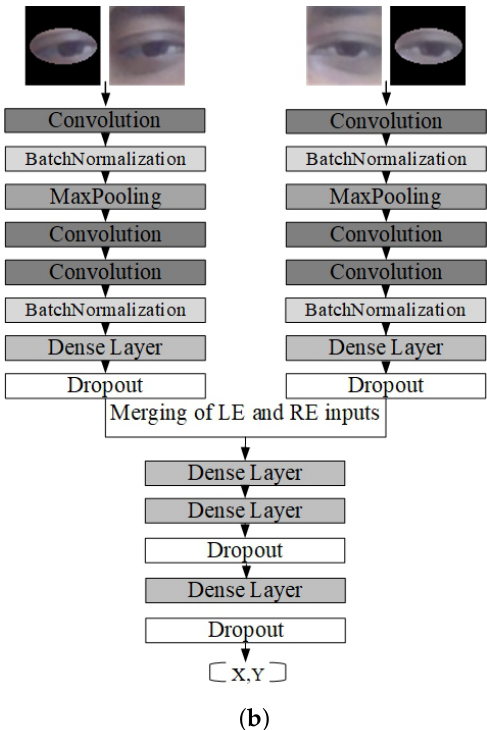
Figure 3. The architectures of the network used in the study. ( a ) Architecture that takes normal eyes, mask eyes, and face image as input. ( b ) Architecture that takes both left and right eyes (with or without mask) as a single input.